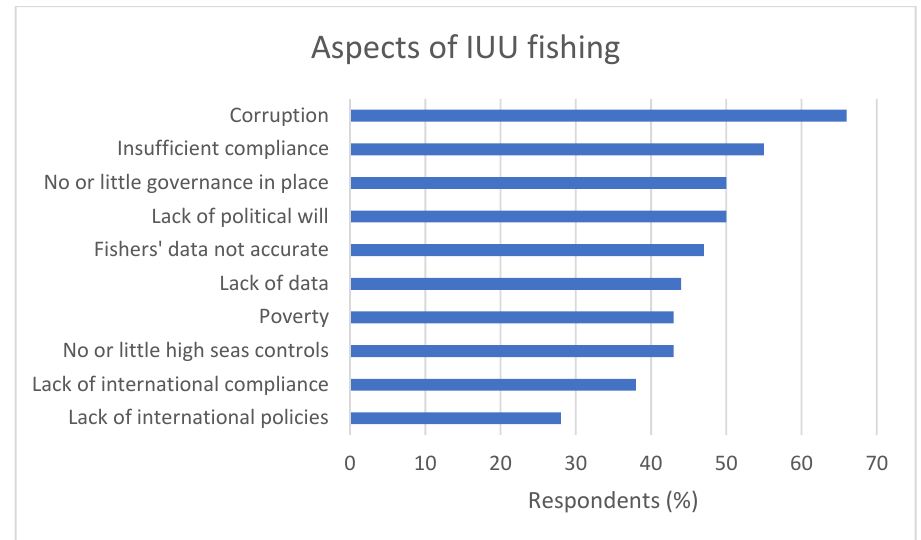
Figure 6. Key aspects of illegal, unreported and unregulated (IUU) problems identified by the respondents.